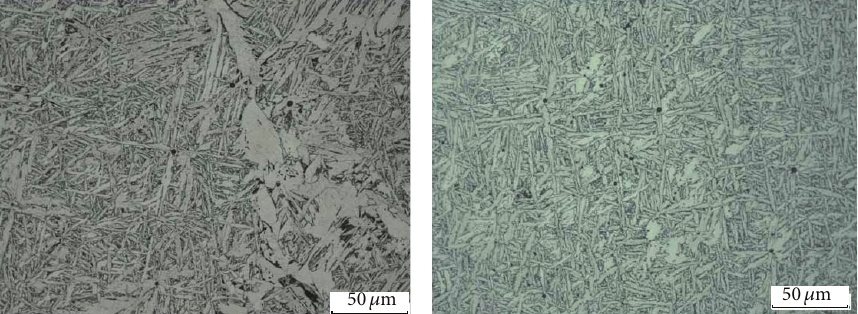
Figure 3: The sample’s optical microstructure.